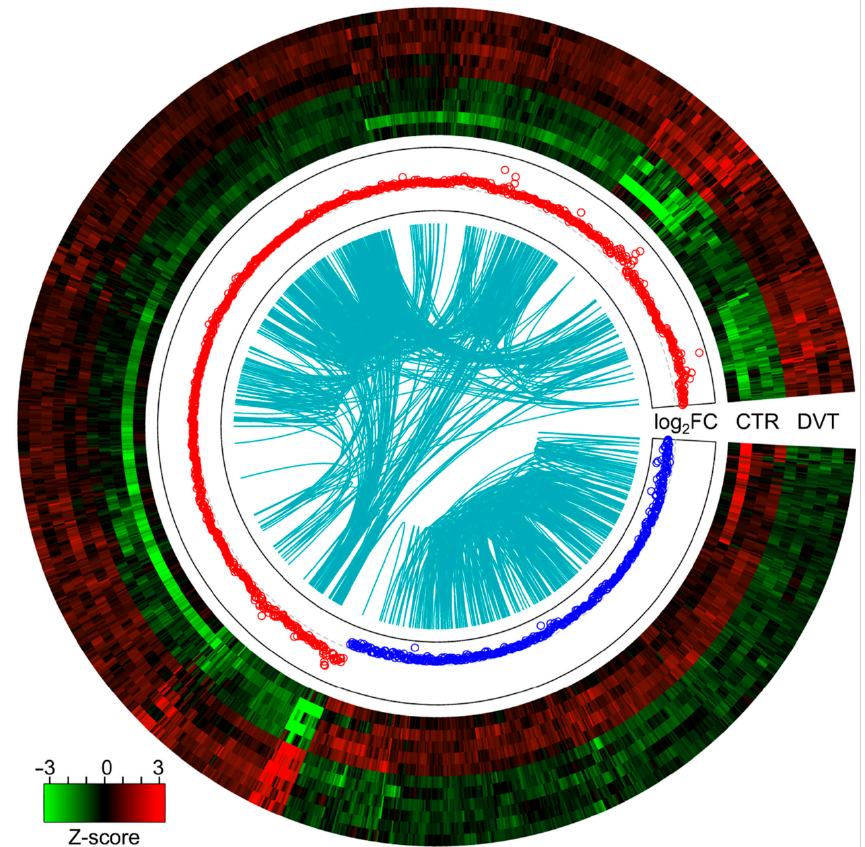
Figure 2. Circular heatmap visualization of differentially expressed genes (DEGs) in the incidence of the DVT. The 11 upper tracks visualize the normalized (Z-score; red-green scale) expression profiles for DEGs in each biological replicate (DVT—deep vein thrombosis and CTR—control libraries). The middle track describes increased (red) and decreased (blue) expression (logFC) in the compared groups. The most-inner track shows the correlation links between the co-expressed DEGs, whereas blue links depict positive Euclidean correlation >